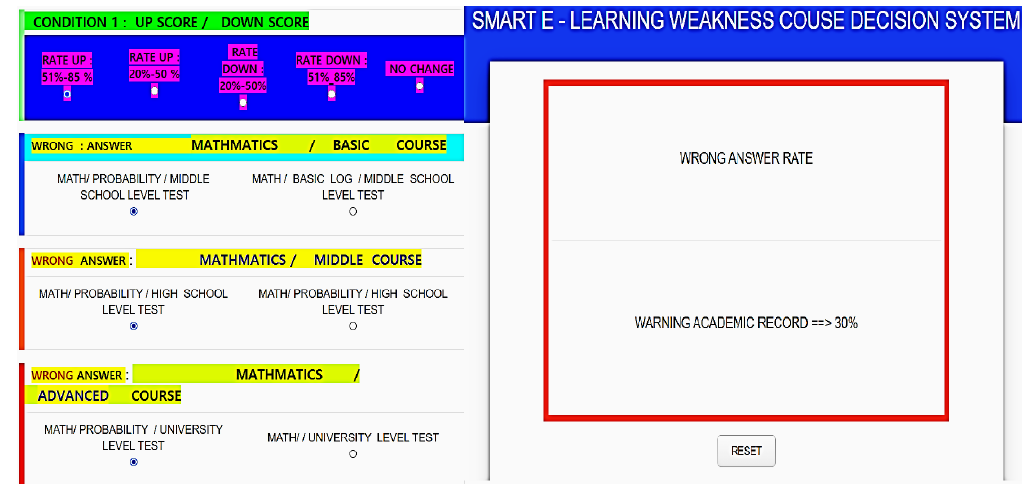
Figure 2. Simulation result of level test.